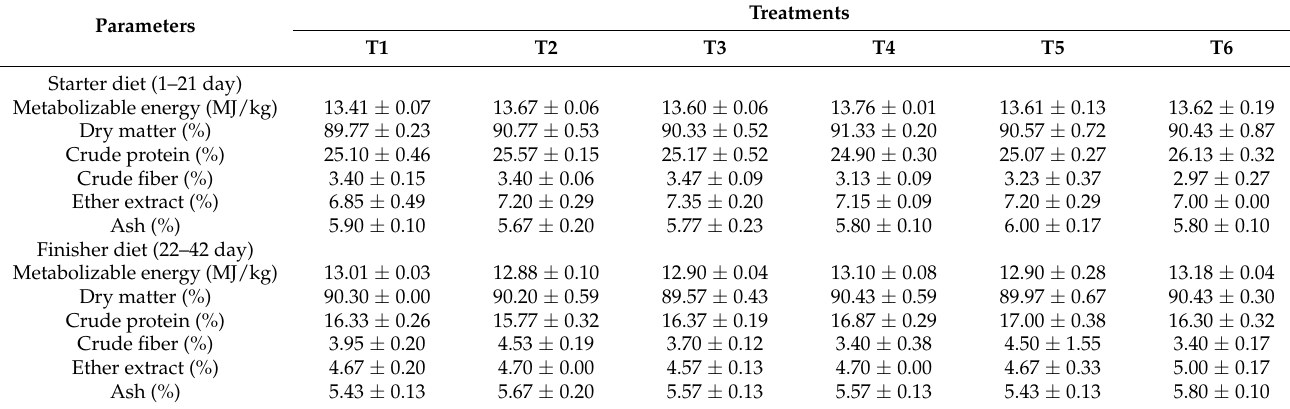
Table 1. Nutrient content of broiler diets supplemented with Y. schidigera at different concentrations. Parameters